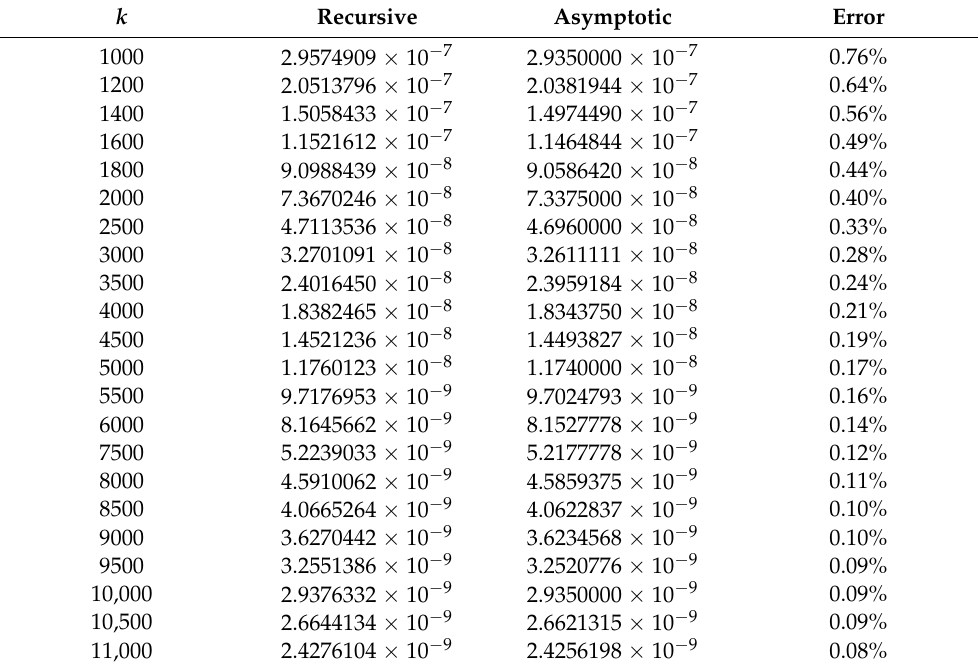
Table 2. Comparison of exact and asymptotic p k . m = 58.7, (cid:101) = 0.005, w = 1.0.